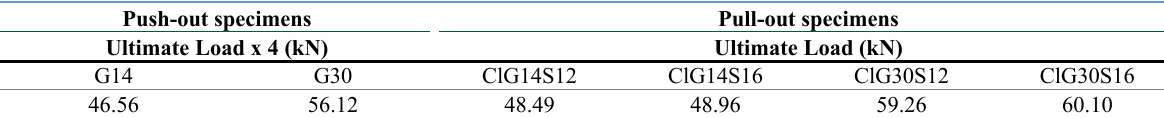
Table 4. Load limited by bond and ultimate load of the pull-out tests of clay blocks [11]. Push-out specimens Pull-out specimens Ultimate Load x 4 (kN) Ultimate Load